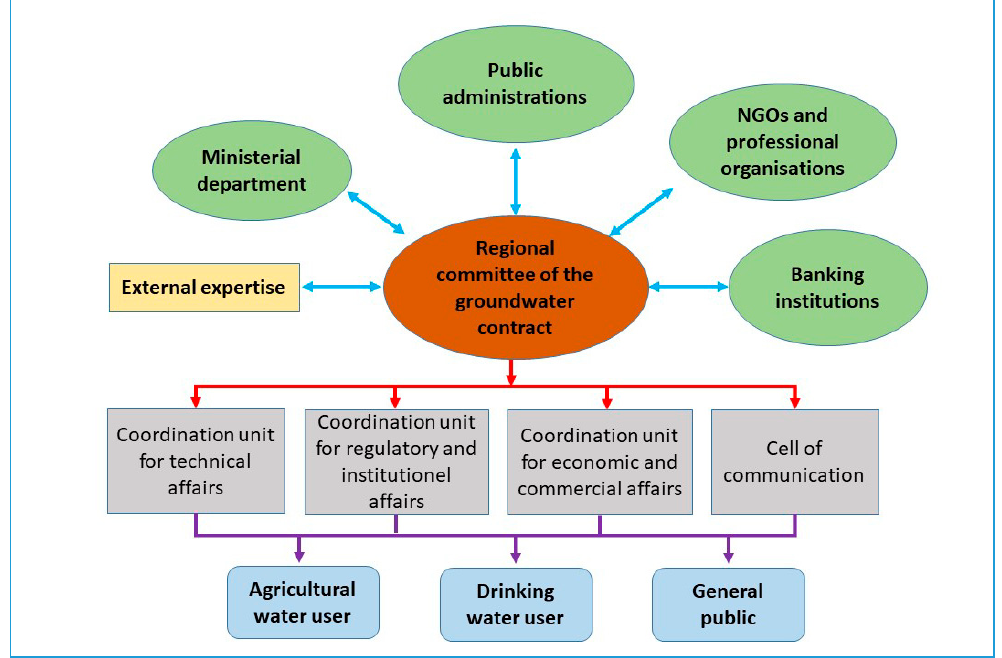
Figure 13. Scheme for implementing the Souss-Massa groundwater contract.